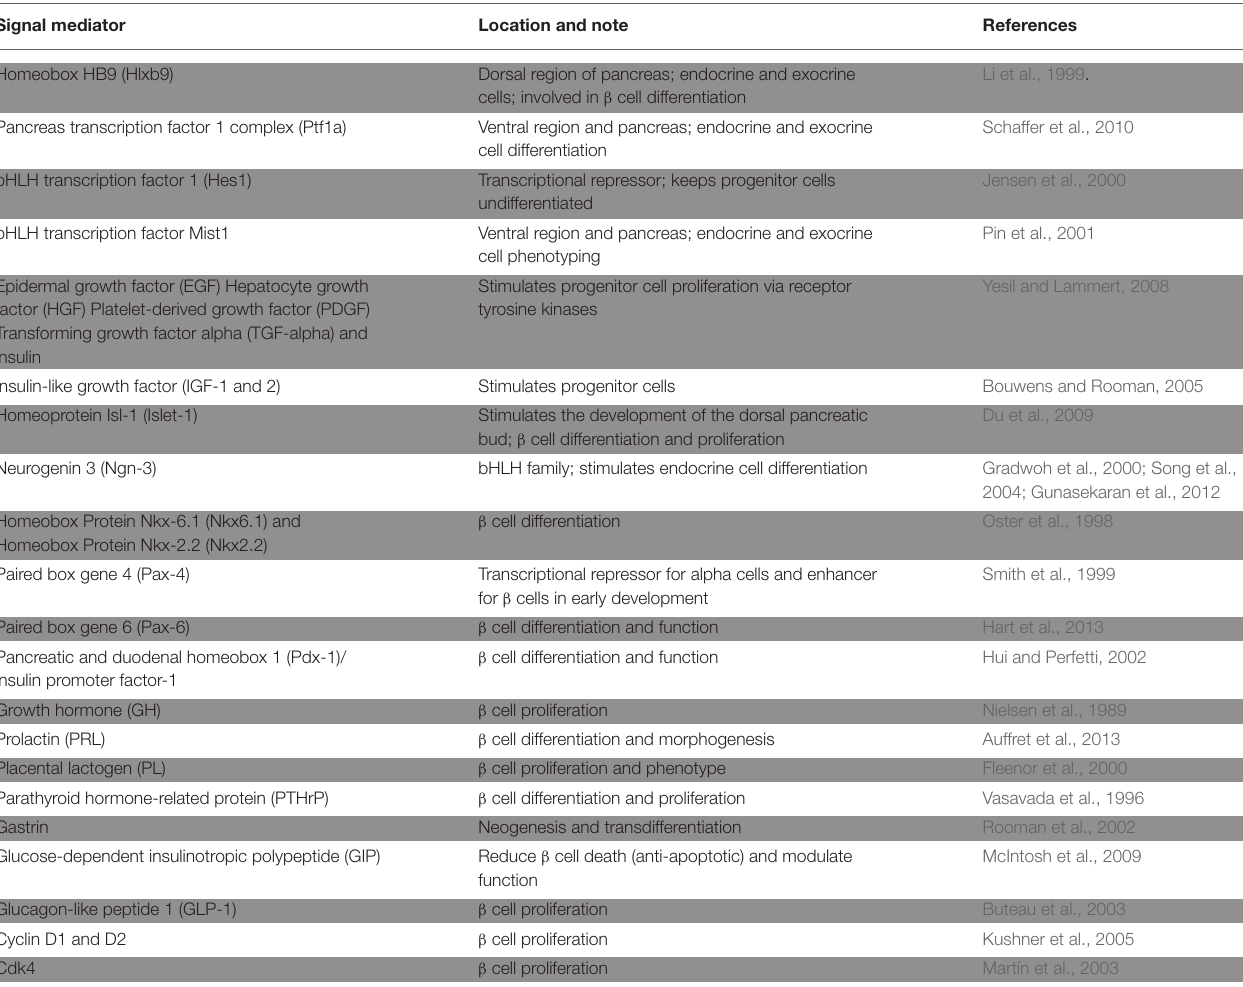
TABLE 2 | Signals that affect pancreatic development and